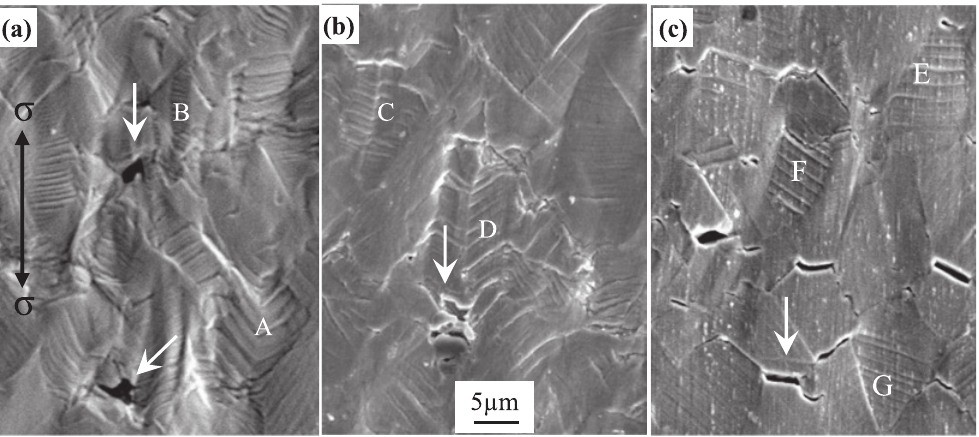
Fig. 7: Surface morphology near the fracture of GH4169 alloy stretched at different temperature. (a) Stretching at 20 °C, (b) stretching at 500 °C, (c) stretching at 650